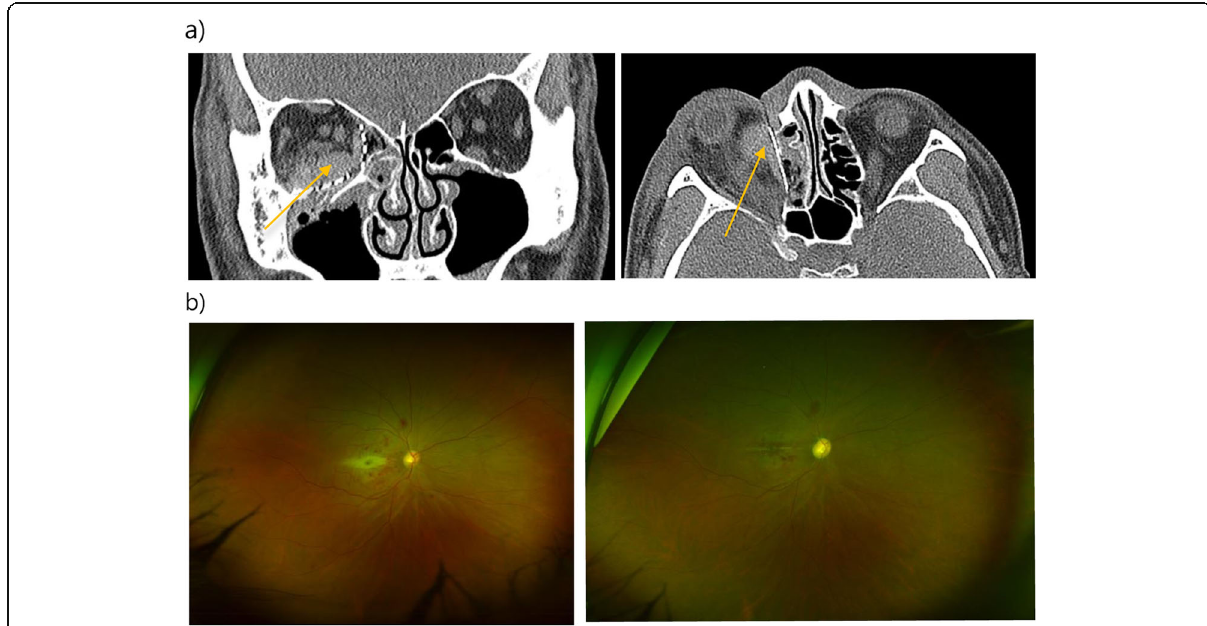
Fig. 3 Postoperative CT images and fundus photographs. a Postoperative CT images of coronal and axial sections. The right medial and inferior orbital walls were reconstructed, and the med-por was properly located. However, a soft tissue density lesion was founded in left extraconal space along the medial and inferior orbital wall, indicating a retrobulbar hematoma (yellow arrow). b Left: fundus photograph of the right eye